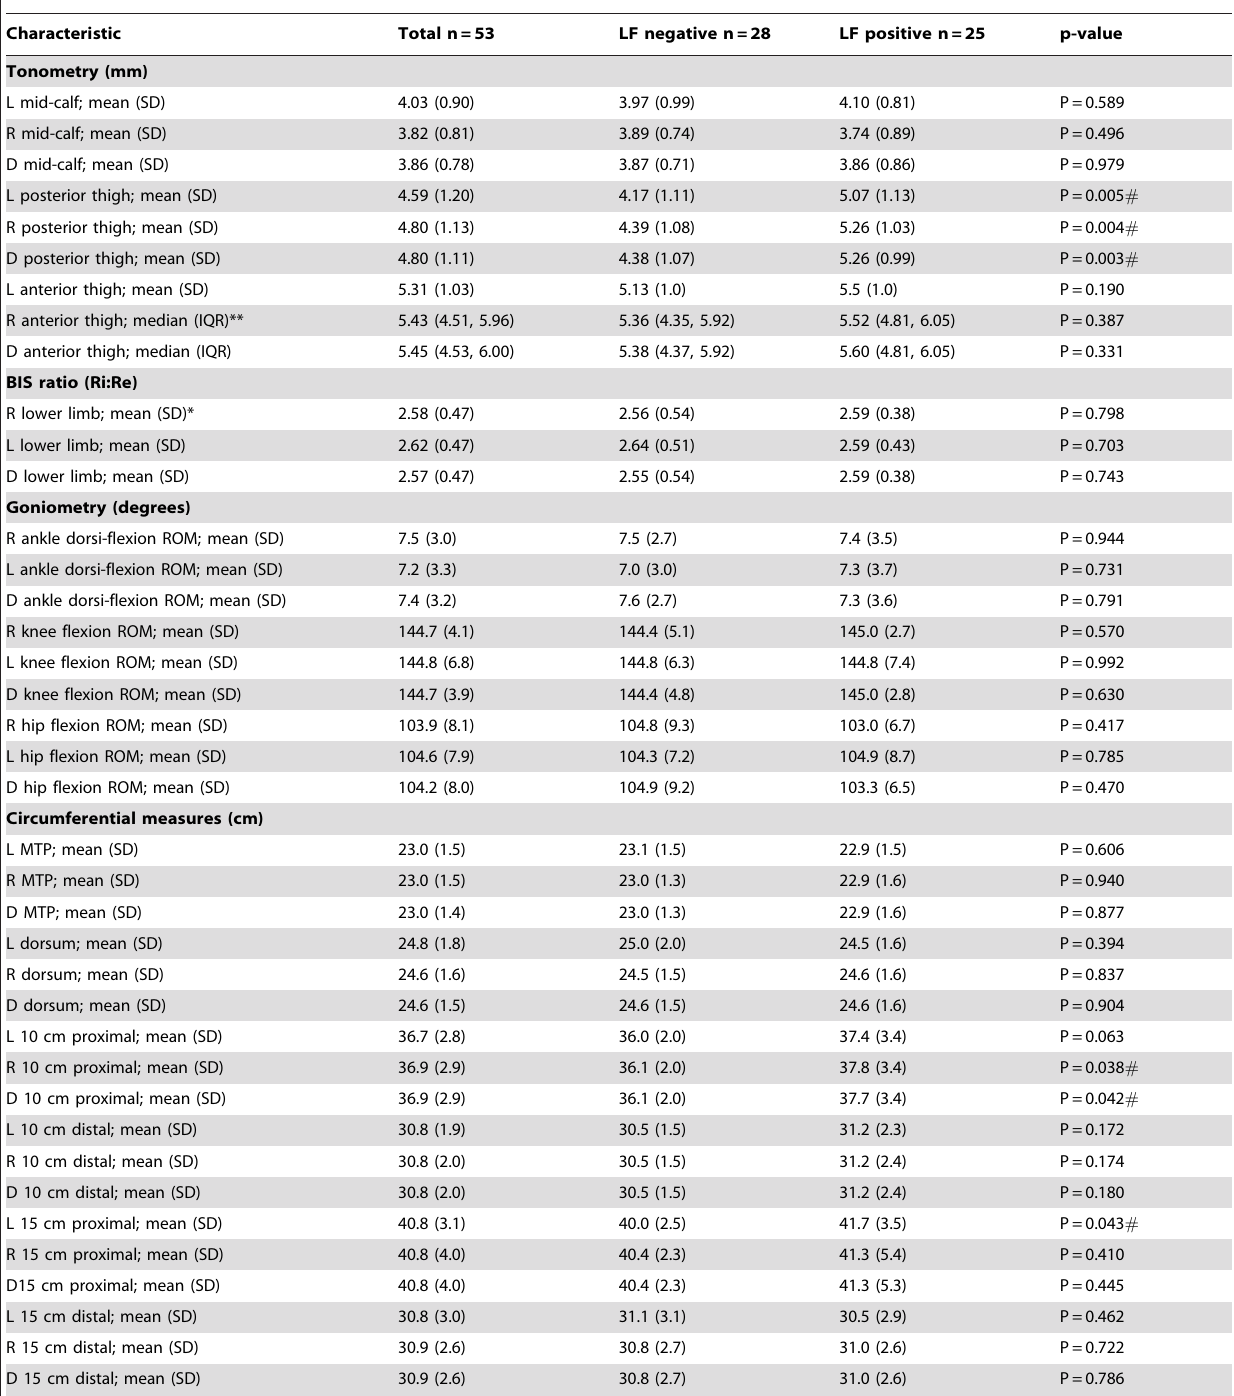
Table 2. Bioimpedance, range of motion, circumferential and tonometry measures for all participants and stratified for LF status.